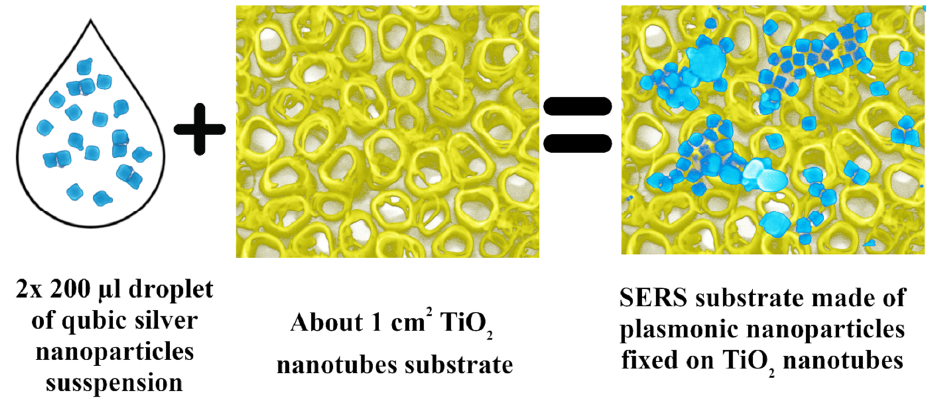
Figure 2. Scheme of preparation surface-enhanced Raman scattering (SERS) substrate based on titanium oxide nanotubes and cubic silver nanoparticles.